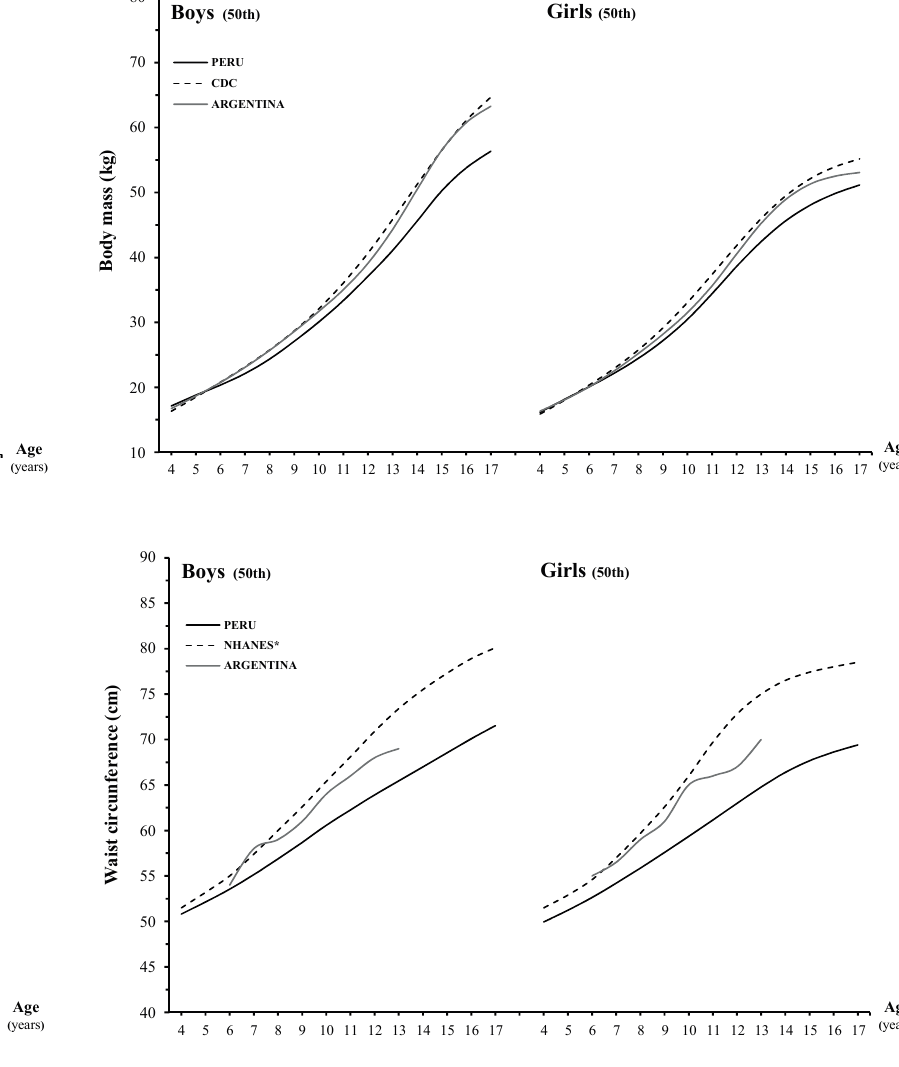
Figure 3. Comparison of the age and sex specific 50th percentile values for height, body mass, body mass index and waist circumference between Peruvian boys and girls and those from North-America and